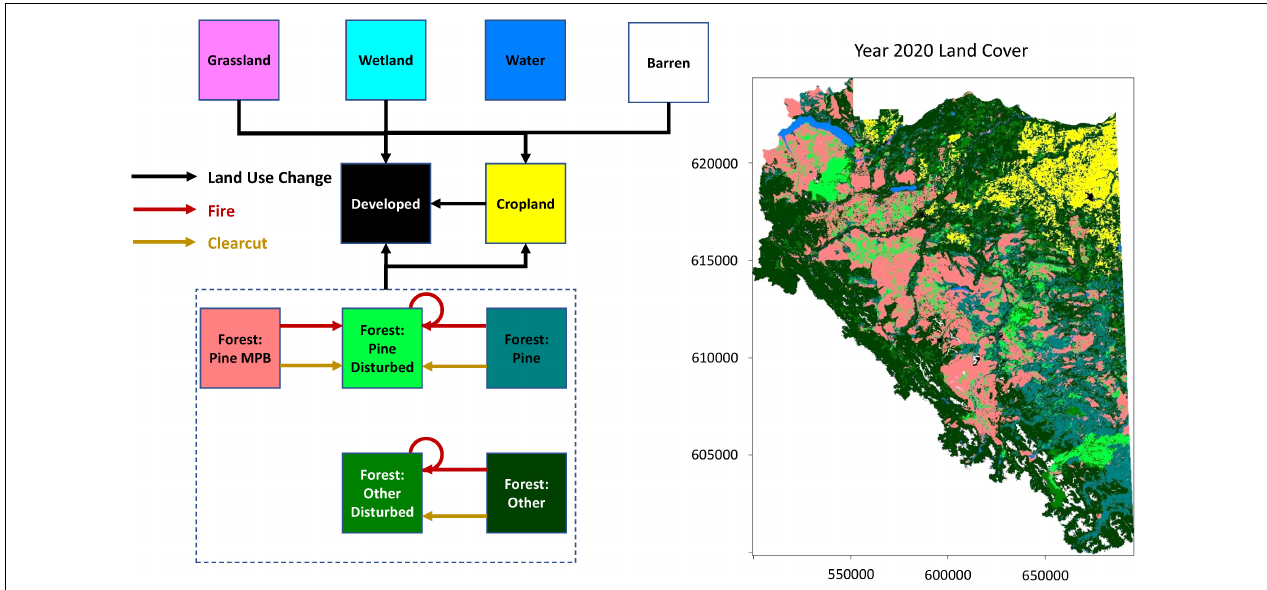
FIGURE 1 | Transition diagram for state-and-transition simulation model for the Dawson Creek Timber Supply Area in the southern Peace River region of British Columbia, Canada. Squares indicate states, and arrows indicate possible transitions between states. Broken rectangle encompasses all forest states, all of which can transition to developed land or cropland via land use change. Map of study area shows land cover in 2020.